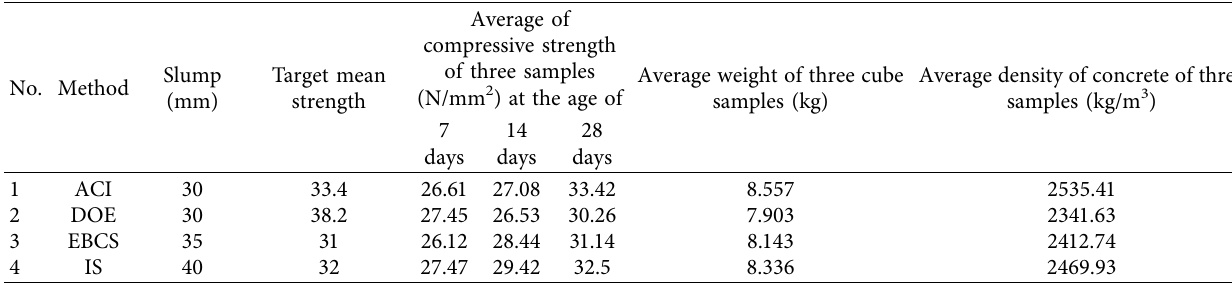
Table 6: Concrete’s average compressive strength and density.